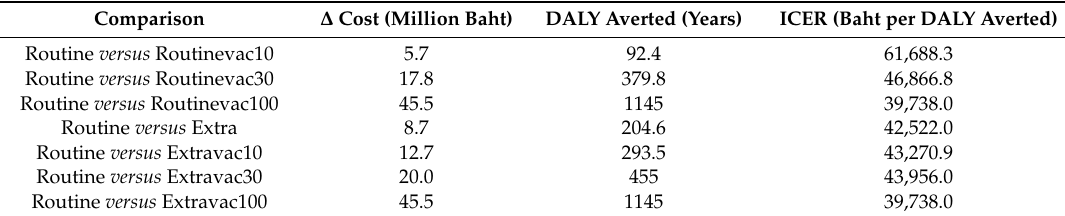
Table 6. ICER of all scenarios (focusing on disease control